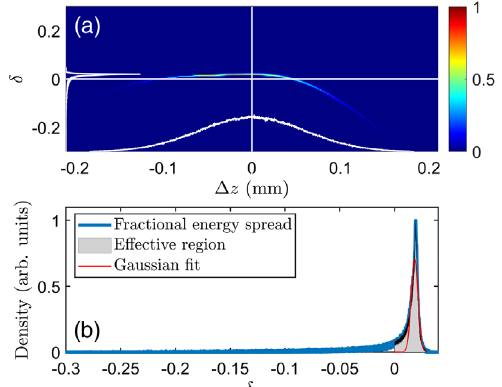
FIG. 18. (a) Longitudinal phase space of the electron beam after propagation through 1 m plasma source. Electron beam head is placed at positive Δ z , whereas the tail is located at negative Δ z . (b) Fractional energy spread distribution. Shaded area is consid- ered to calculate effective RMS energy spread. Red line is the Gaussian fit